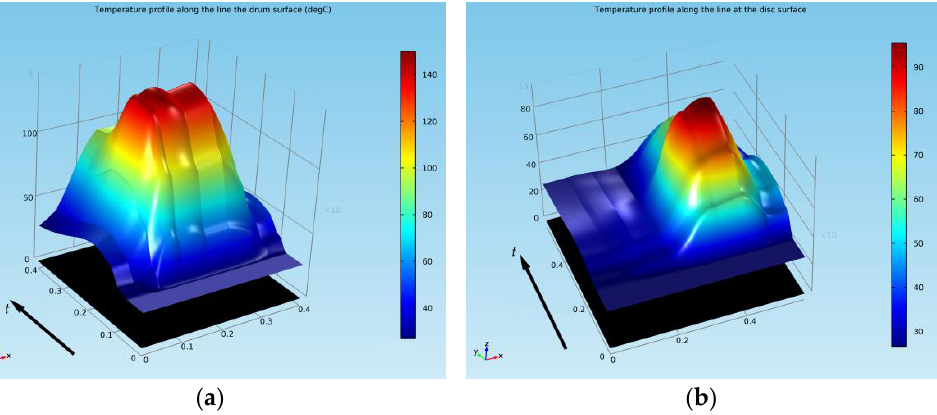
Figure 23. Temperature versus time profile along the 3D cut line for: ( a ) drum-and-shoe brake system; ( b ) disc-and-pads brake system.